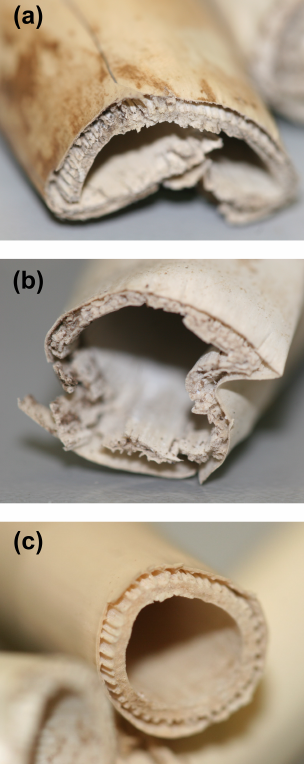
Figure 8. P. australis rhizomes after 75d of anaerobic decomposi- tion in the three peat substrates. (a) High-N substrate (detritus mud), (b) medium-N substrate (sedge–brown-moss peat), and (c) low-N substrate ( Sphagnum